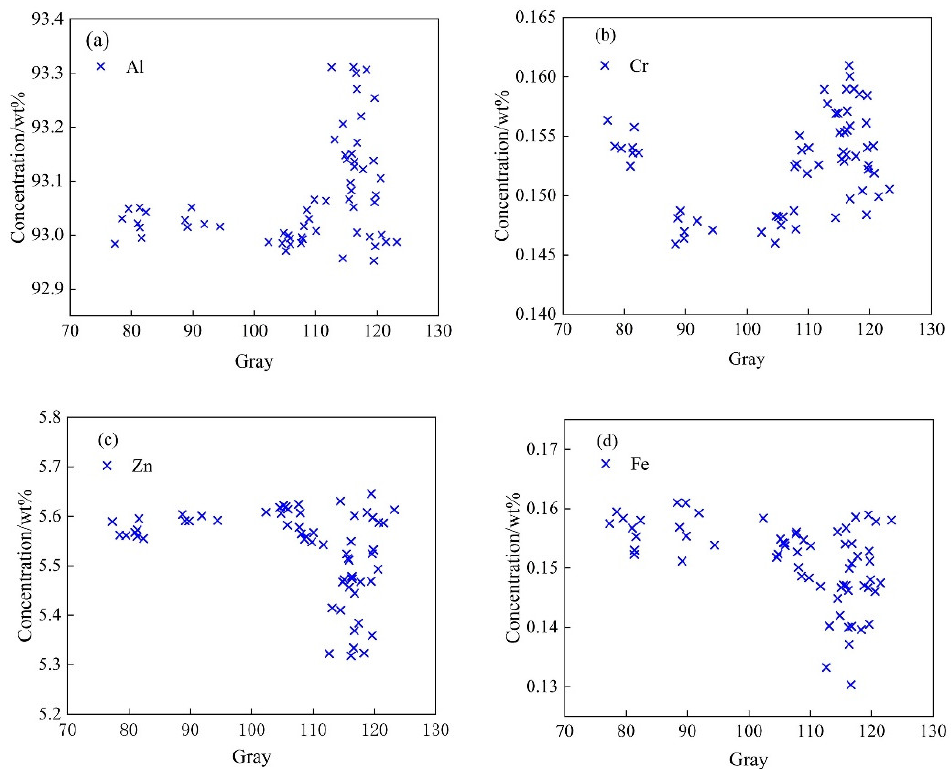
Figure 13. Statistical mapping diagram of grayscale and component data in the T4-6 aluminum alloy microregion. ( a ) Al element; ( b ) Cr element; ( c ) Zn element; ( d ) Fe element.